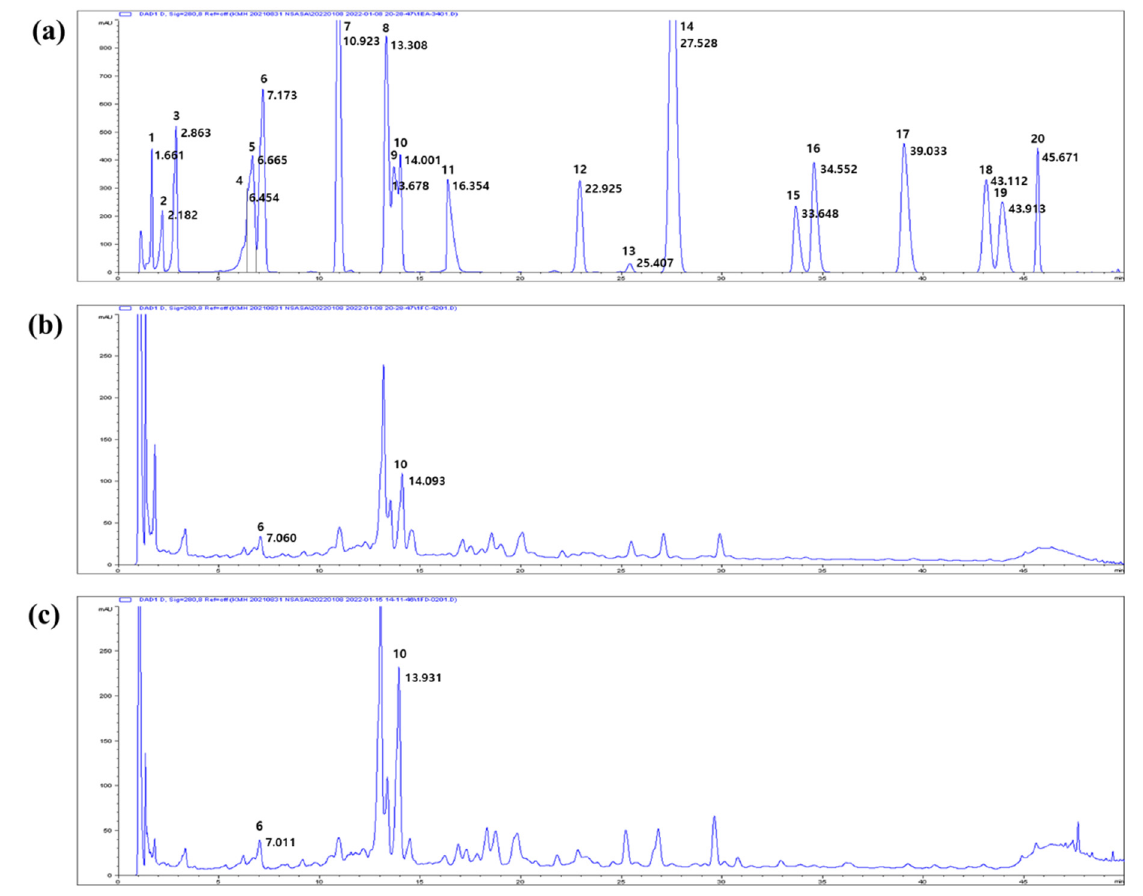
Figure 3. HPLC of phenolic compounds in SB extracts. ( a ) The peaks represent the following phenolics (0.5 mg/mL): 1, gallic acid; 2, homogentisic acid; 3, protocatechuic acid; 4, chlorogenic acid; 5, vanillic acid; 6, caffeic acid; 7, p -coumaric acid; 8, ferulic acid; 9, veratric acid; 10, isoorientin; 11, ellagic acid; 12, naringin; 13, rosmarinic acid; 14, cinnamic acid; 15, quercetin; 16, luteolin; 17, naringenin; 18, apigenin; 19, kampferol; 20, tricin. ( b ) Sasa borealis water extract (SBW), ( c ) Sasa borealis ethanol extract (SBE). Table 2. Phenolic acid (caffeic acid) and flavonoid (isoorientin) contents of SB extracts by HPLC. No. Phenolic